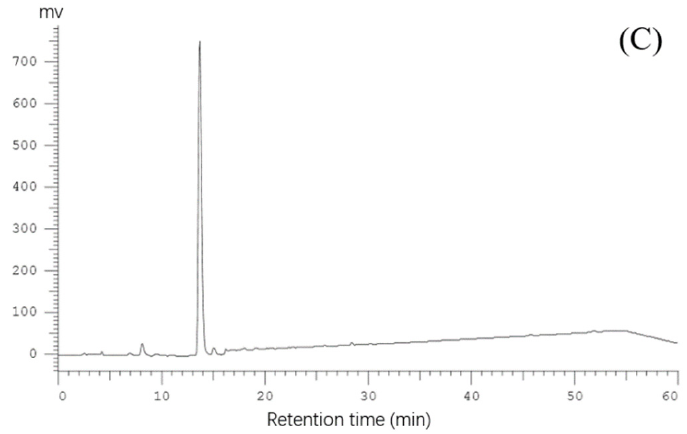
Figure 5. Elution profile of fraction loaded on Xselect TM CSH130 (Ø4.6 × 250 mm, 3.5 µ m). Elution profile of fraction II-2-6-3 ( A ); elution profile of fraction II-2-6-5 ( B ); elution profile of fraction II-2-6-7 ( C ).